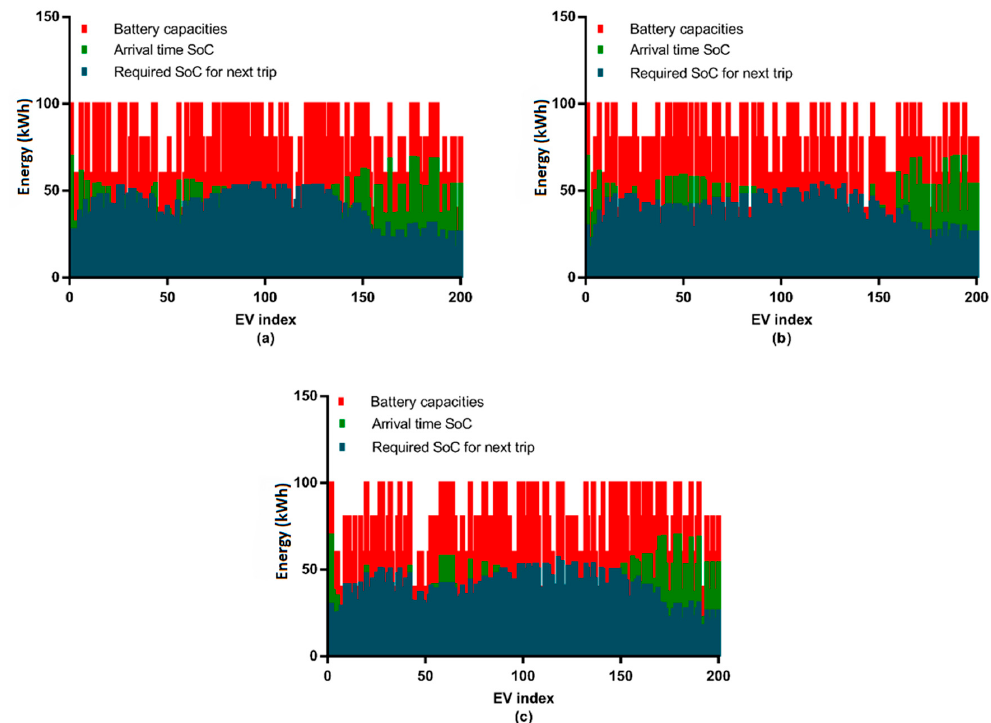
Energies 2020 , 13 , 4634 26 of 31 Figure 11. Battery capacities, arrival time SoC and required amount of energies according to the EVs next trip distances for the PLs connected to the three buses: ( a ) Represents the PL connected to the bus #820; ( b ) Represents the PL connected to the bus #834; ( c ) Represents the PL connected to the bus #844.